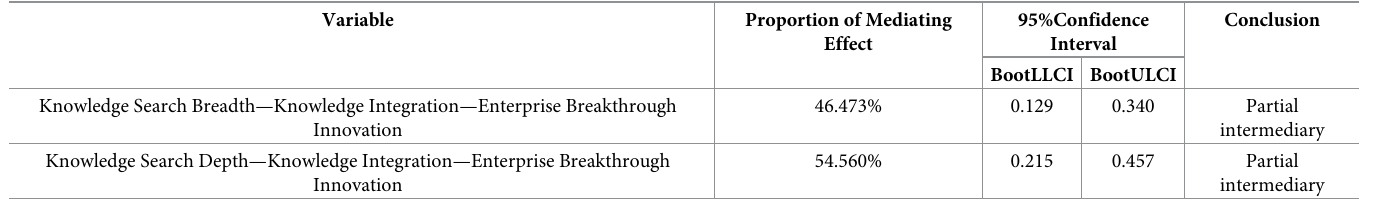
Table 7. Bootstrapping mediating effect test of knowledge integration.